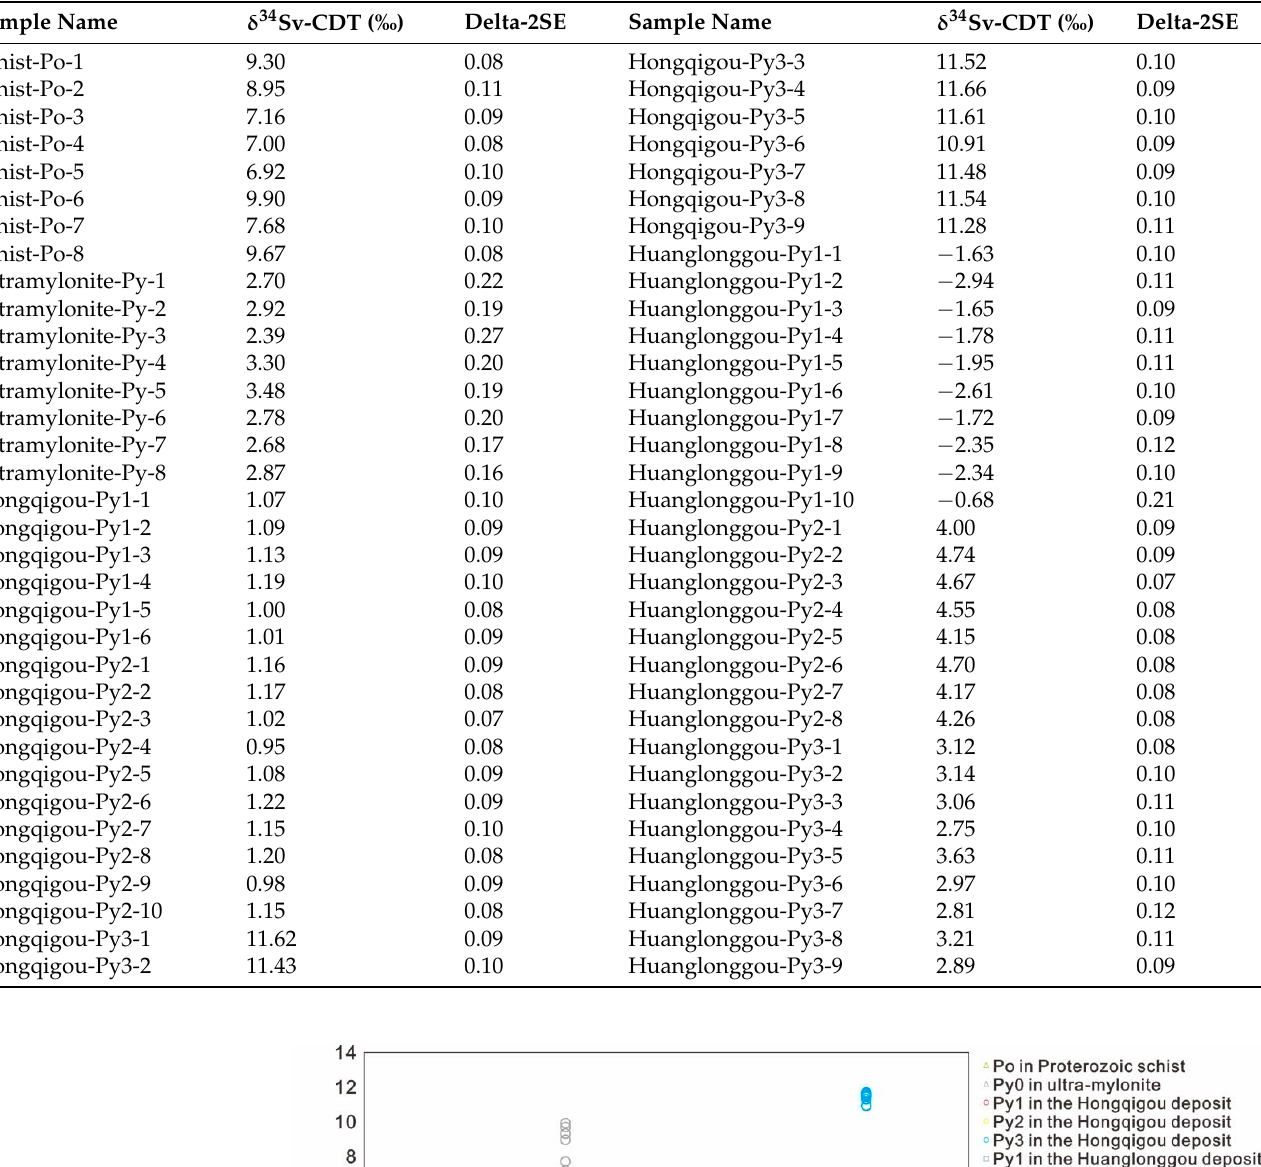
Table 3. The summarized LA-ICP-MS analytical results of sulfur isotope ratios for different gener- ations of pyrite in each stage and pyrrhotite in schist of wall rock in the WGF (ppm, bdl = below detection limit).